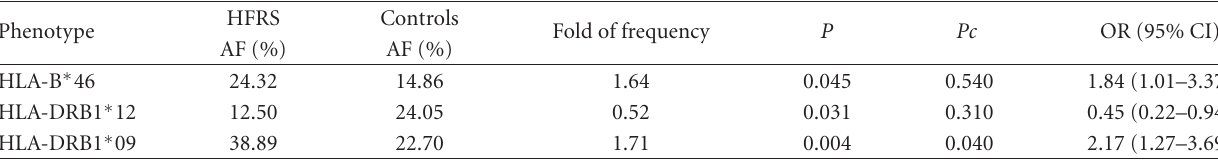
Table 3: Comparison of the phenotype frequencies of major alleles of HLA-A, -B, and -DRB1 in hemorrhagic fever with renal syndrome population and control